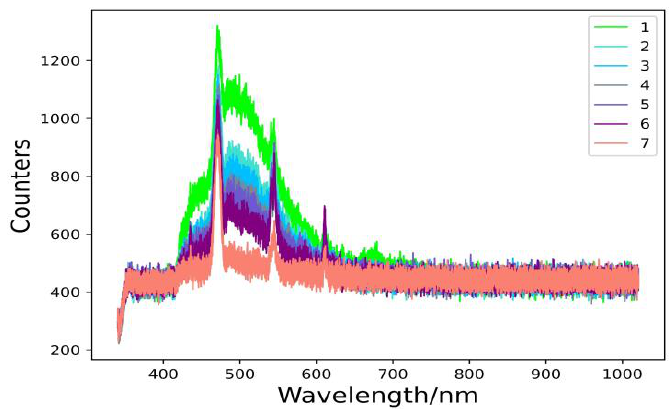
Figure 1. Original spectra.